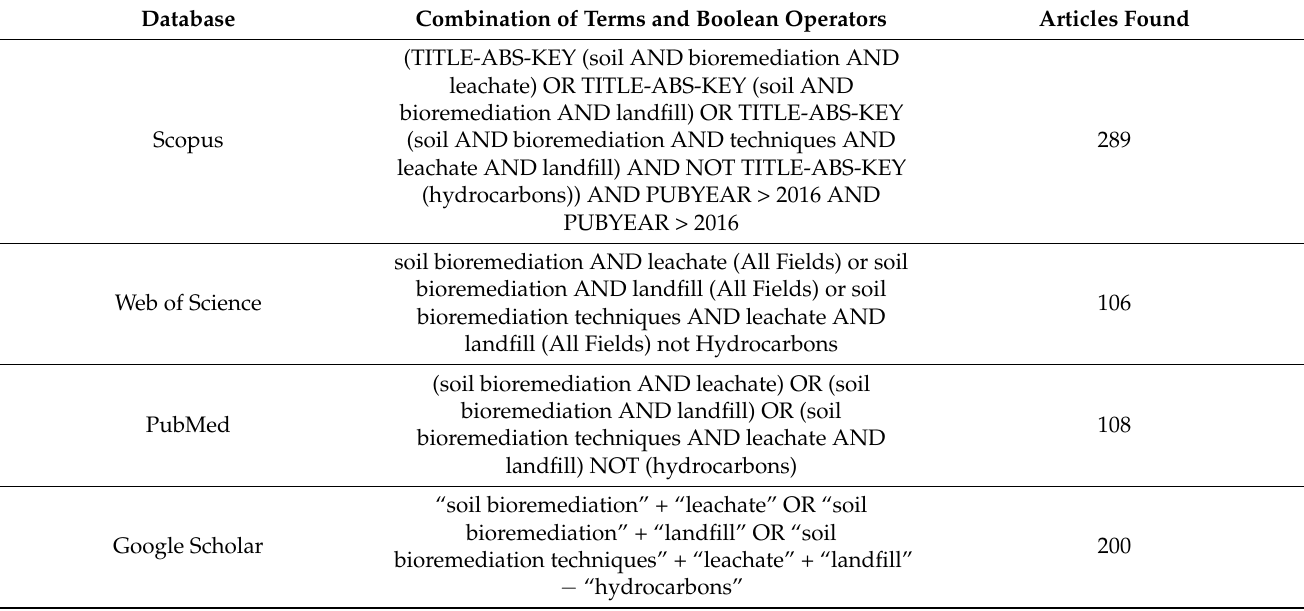
Table 1. Search strategy with Boolean